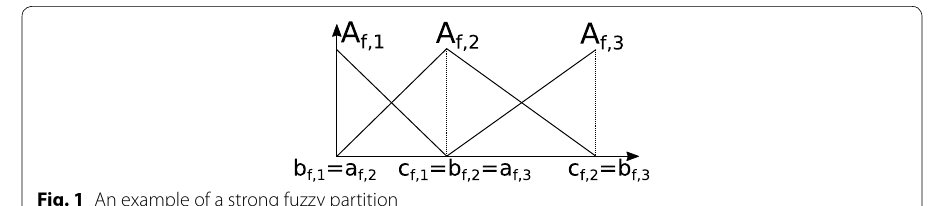
Fig. 1 An example of a strong fuzzy